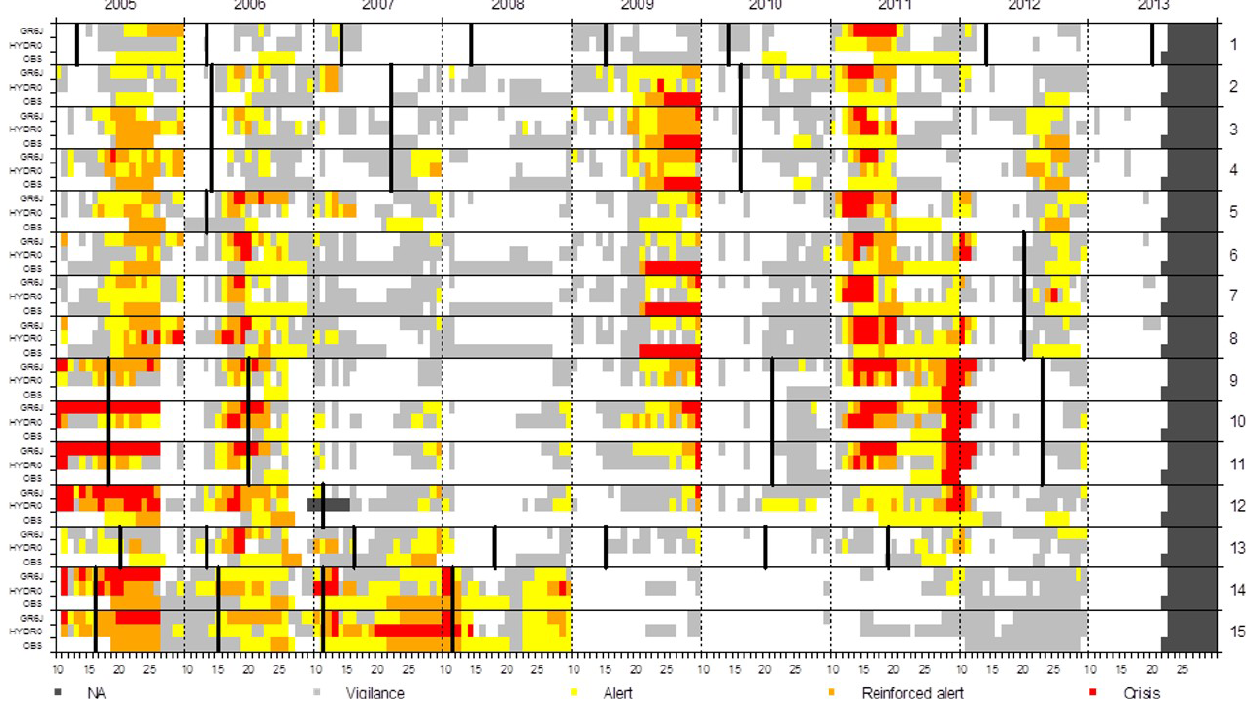
Figure 6. Observed and simulated water-restriction levels considering the two sources of discharge data, GR6J and HYDRO, for each of the 15 evaluation catchments (Table 1). The x abscissa is divided into 10d periods for each year, spanning the period April–October. Black segments identify updated DMPs.